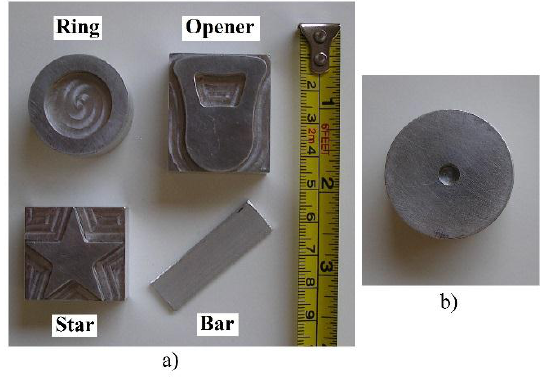
Figure 2. ( a ) Objects used to carry out the experiments (from left to right and top to bottom: ring, opener, star, and bar); ( b ) Hole atop the ring object to insert the tip of the force sensor